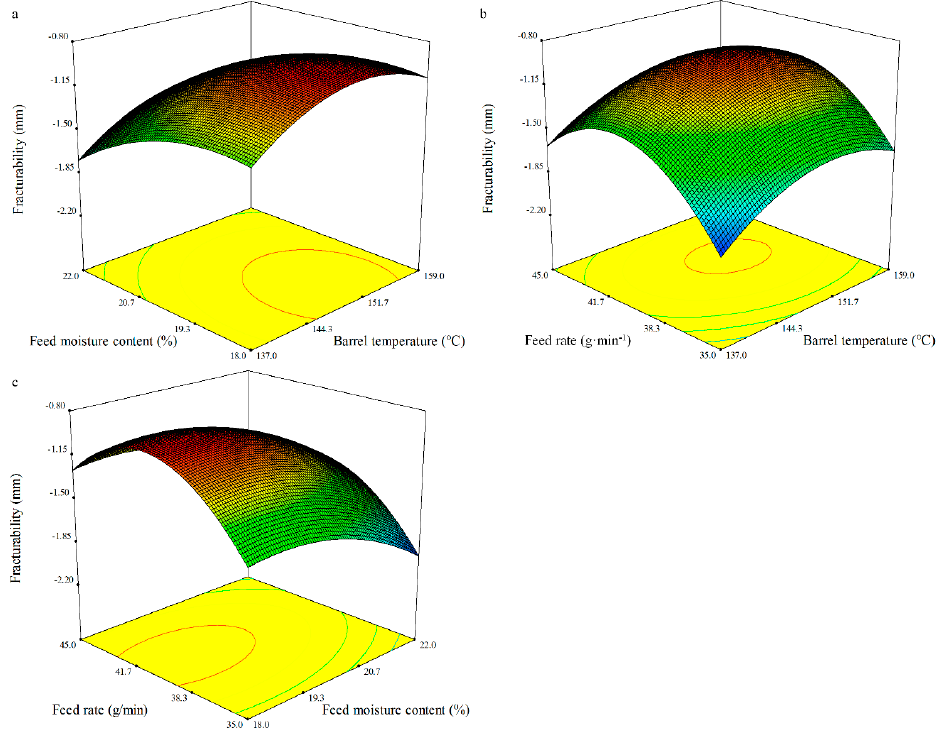
Figure 4. Response surface plot of the fracturability of the whole BGW extrudates.